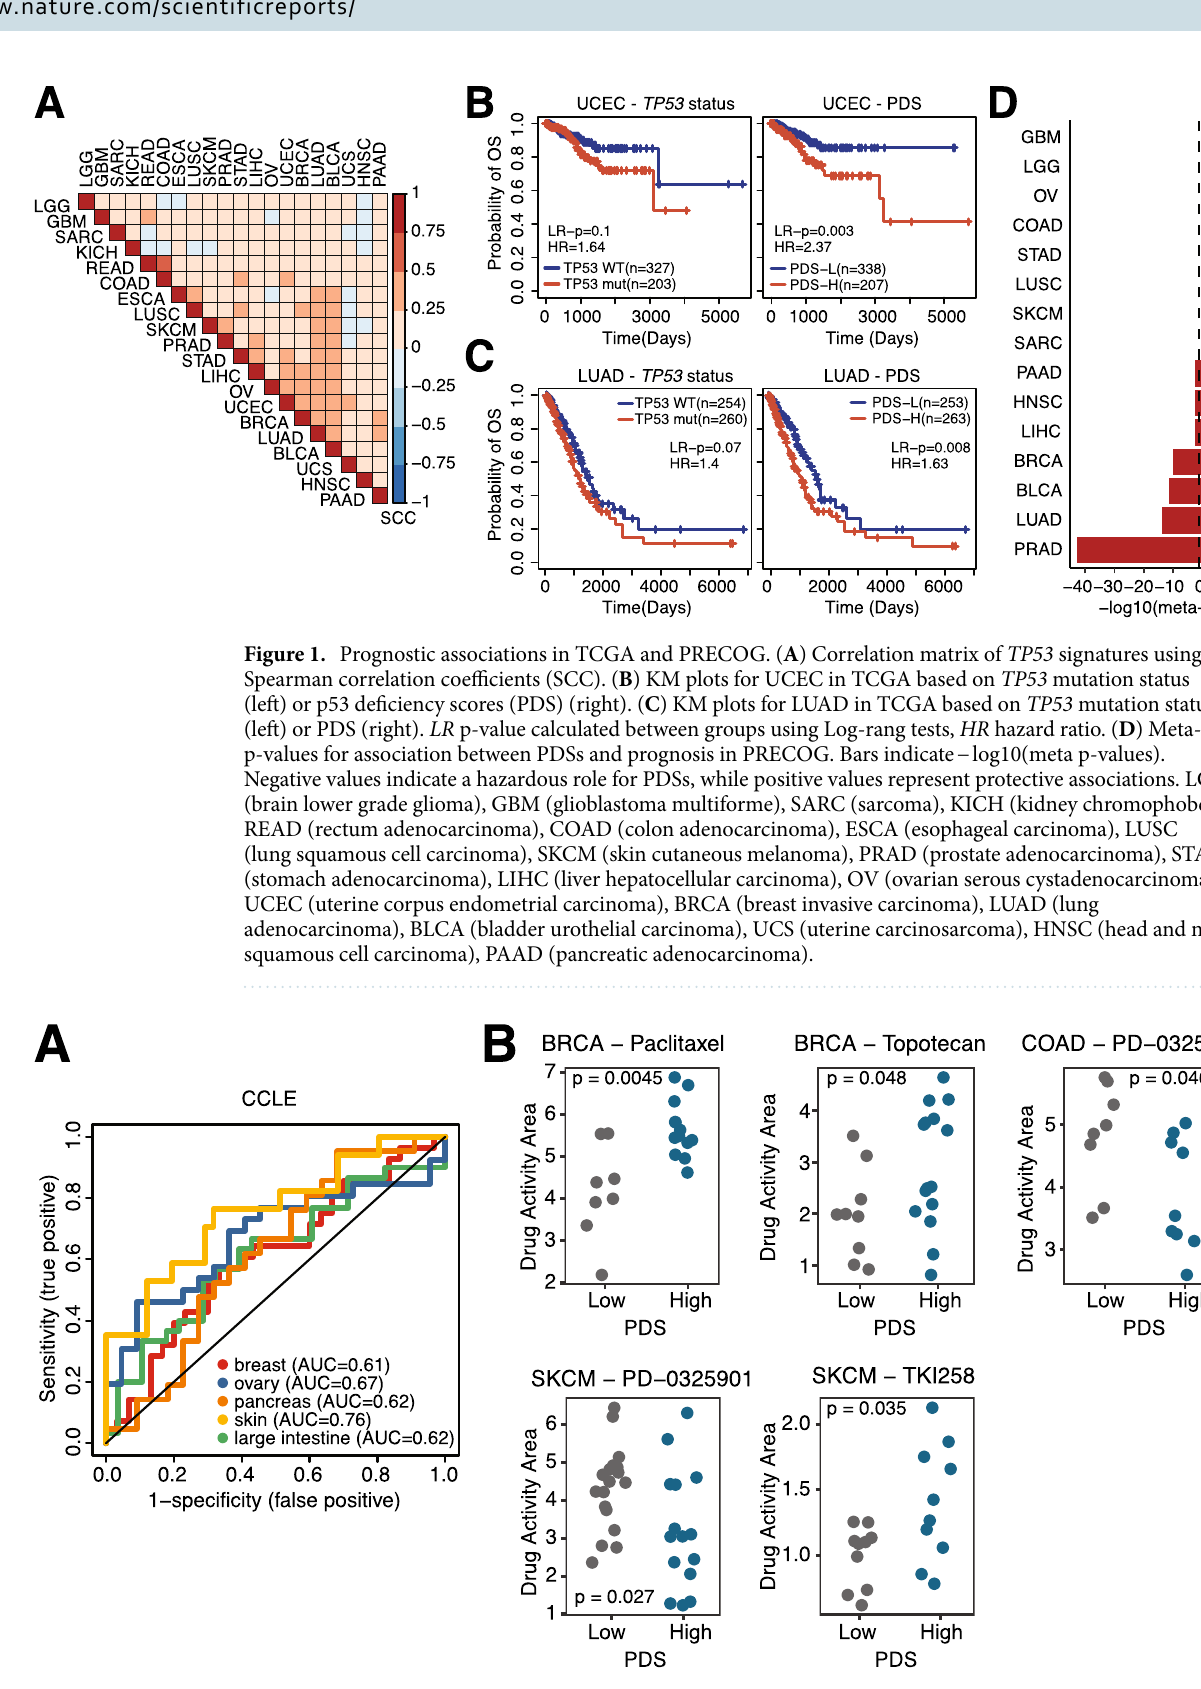
Figure 2. Drug sensitivity in CCLE data. ( A ) AUC curves of PDS predicting TP53 mutation status for cancer types with AUC scores > 0.60. ( B ) Differences in drug sensitivity based on PDS status using the median of PDSs to demarcate low and high p53 deficiency groups. p-value calculated by two-sided Student’s